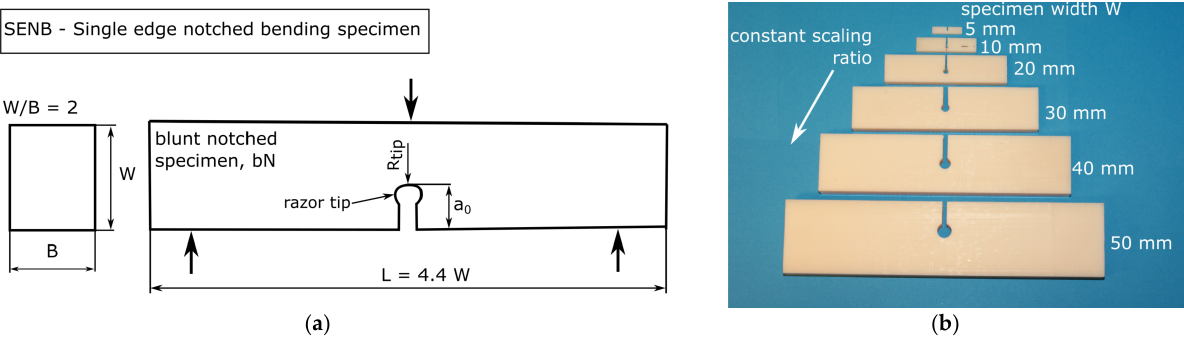
Figure 5. Blunt single-edge notched bending (SENB) specimen geometry and testing setup ( a ). Constant scale-up ratio for specimen width W with the manufactured blunt notched ABS specimens ( b ) (adapted from [7] with permission).